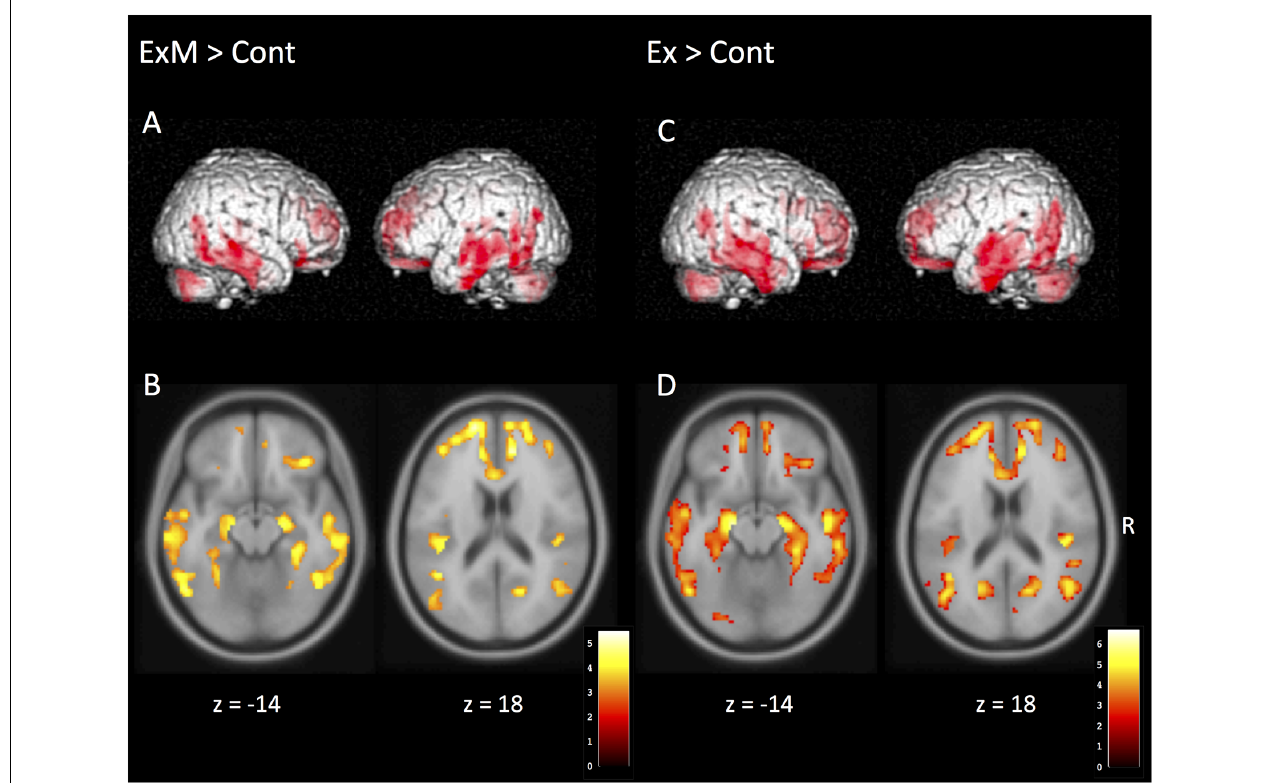
FIGURE 2 | Regions showing a significant post-intervention increase in gray matter volume in the ExM, Ex, and Cont groups. (A,B) Gray matter volume was larger in the ExM group relative to the Cont group. (C,D) Gray matter volume was larger in the Ex group relative to the Cont group. Cont, control group; Ex, physical exercise without music group; ExM, physical exercise with music